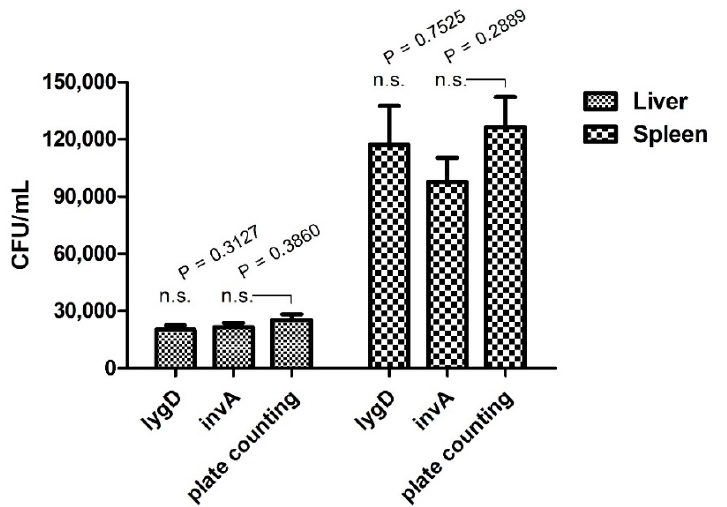
Figure 2. Quantification analysis of the duplex real-time PCR for S. enteritidis in a chicken infection model. SPF white Leghorn chickens were infected with the indicated concentrations of bacteria in 0.2 mL phosphate-buffered saline orally. The spleens and livers were collected for analysis of bacterial burden. Organs were collected and homogenized. The serial 10-fold dilutions were plated on LB agar. The data represent the number of CFU/mL in 10 − 3 dilution of organs. n.s. indicates no significant